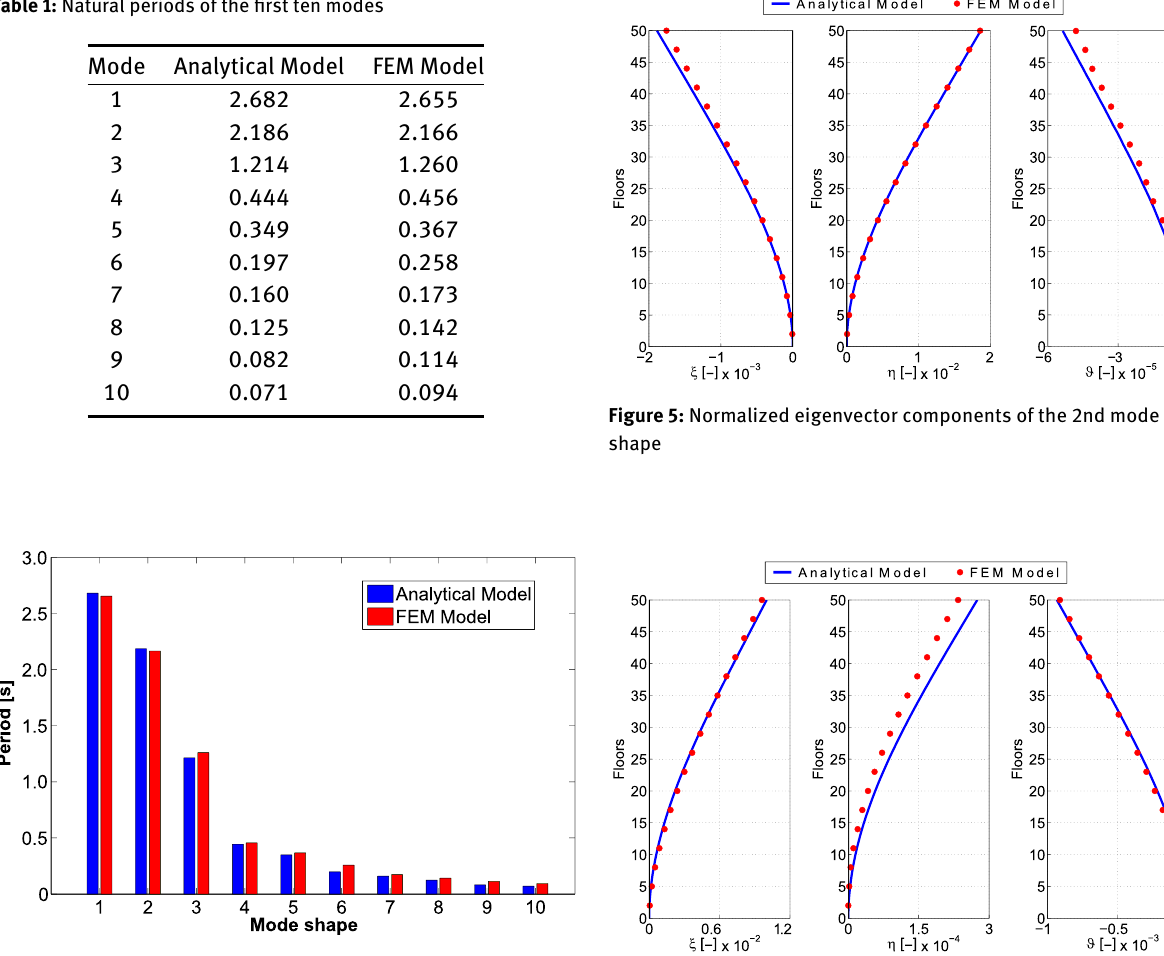
Figure 3: Natural periods of the first ten modes